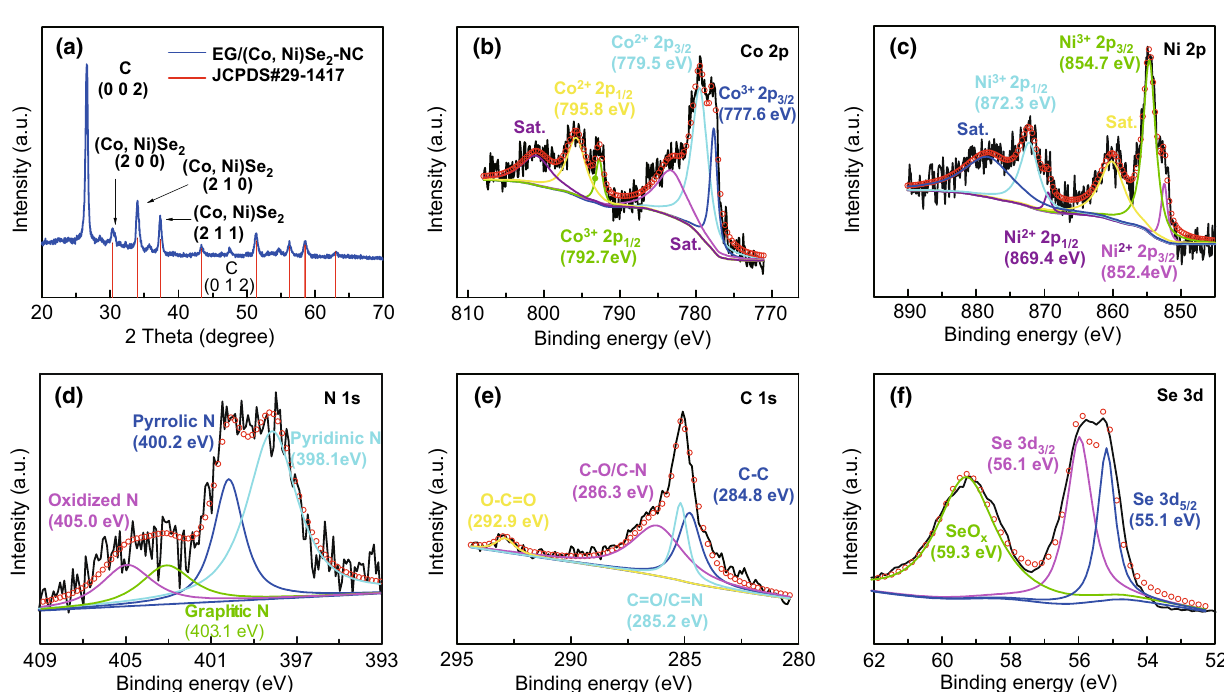
Fig. 3 a XRD pattern of EG/(Co, Ni)Se 2 –NC. b – f high-resolution XPS spectra of Co 2 p , Ni 2 p , N 1 s , C 1 s , and Se 3 d in EG/(Co, Ni)Se 2